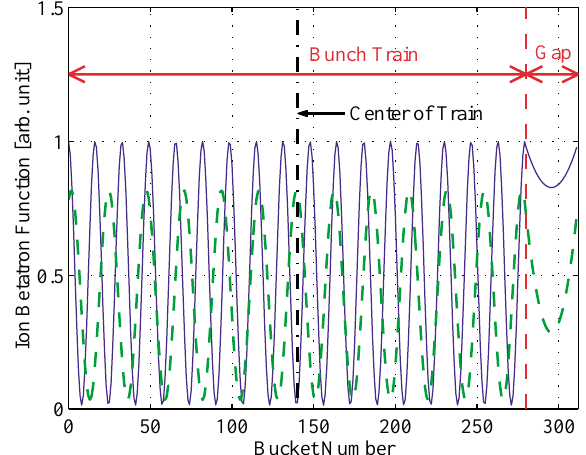
FIG. 8. (Color) Ion betatron functions (solid-blue and dashed- green curves) at two different locations in the